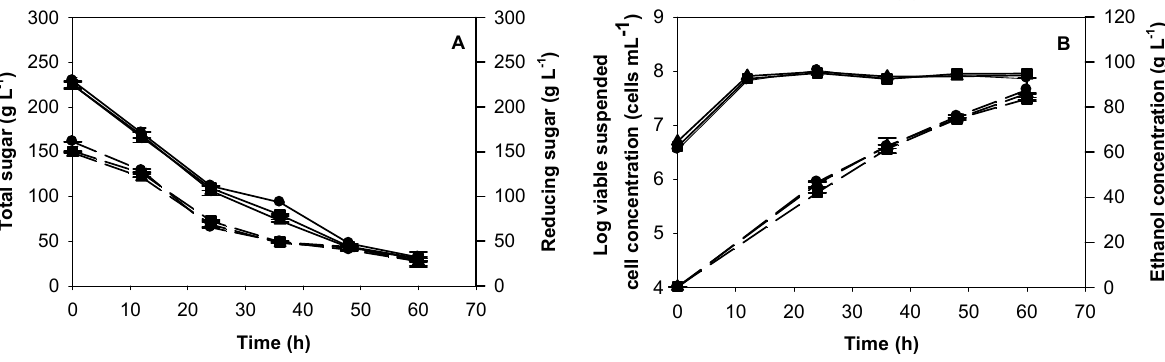
Figure 1. Batch culture profiles of ethanol production from sweet sorghum juice by S. cerevisiae NP 01 immobilized on 6 × 6 × 6 ( ● ), 12 × 12 × 12 ( ▲ ) and 20 × 20 × 20 ( ■ ) mm 3 sorghum stalks. ( A ) Total sugar (solid lines) and reducing sugar (dash lines); ( B ) log viable suspended cell concentration (solid lines) and ethanol concentration (dash